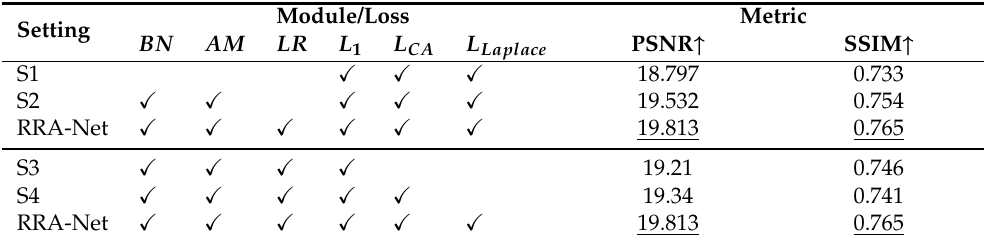
Table 2. Ablation studies on main modules of MRAB (top rows) and on two new loss functions (bot- tom rows). BN , AM , and LR stand for batch normalization, attention module (spatial attention and channel attention), and local residual connection in MRAB, respectively. Best results are underlined.